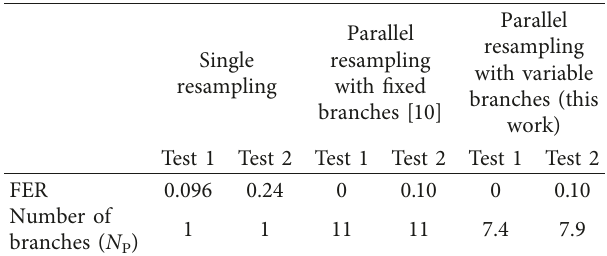
Figure 17: Measured Doppler shifts for frame numbers of 33, 49, and 102 in Test 1. Table 7: Summary of experimental